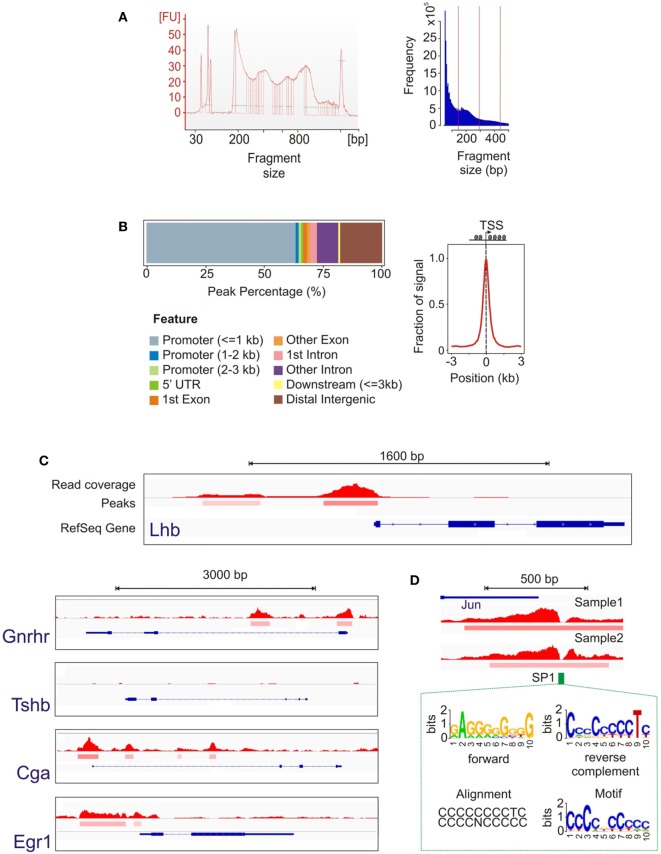
Assay for transposase-accessible chromatin with high-throughput sequencing (ATAC-seq) data analysis. (A) Library and sequence fragment size distribution showing a periodicity characteristic of the effect of nucleosome binding. (B) Position of open chromatin peaks with respect to genomic features shows their genome-wide distribution are concentrated around the active transcription start sites (TSS), indicating that TSS are enriched for open chromatin. (C) Representative loci of genes showing the open chromatin signal. The top track represents the read coverage (density of sequence reads) at each location. The middle peak track indicates genomic regions that achieve statistical significance for chromatin accessibility. The bottom track shows the RefSeq gene annotation (intron/exon locations, transcription direction, etc.). As expected, accessible chromatin segments were detected around the promoter regions for Lhb, Gnrhr, Cga, and Egr1, but not for Tshb. (D) Example of transcription factor binding identification based on the footprint analysis of the open chromatin signal. The notch in the open chromatin region corresponds to the location of a consensus SP1 site. The HOMER analysis suite utilized (40) calculates a data-driven motif model from our ATAC-seq peak data, shown in forward and reverse configurations, and then associates this motif with known motifs. In this example, the known SP1 consensus motif is nearly identical to the data-driven motif.